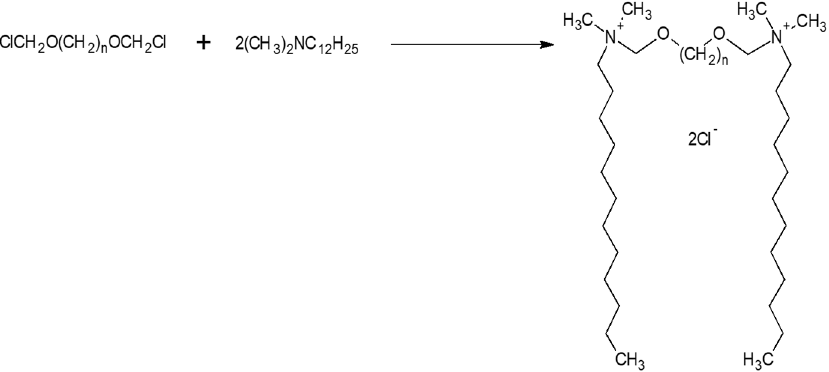
Figure 9. Ammonium gemini surfactants: Synthesized alkanediyl-α,ω-bis[(oxymethyl) dimethyldodecylammonium]